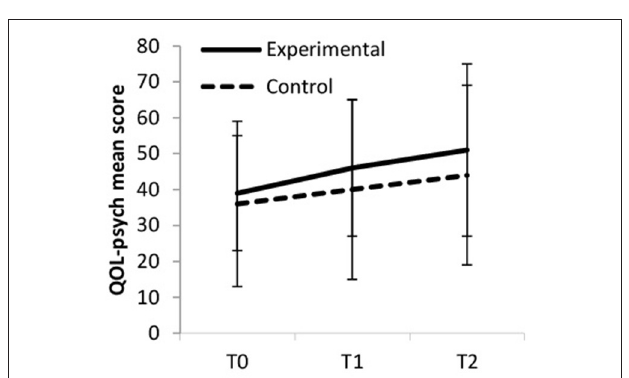
FIGURE 3 | Psychological quality of life (QOL-psych).